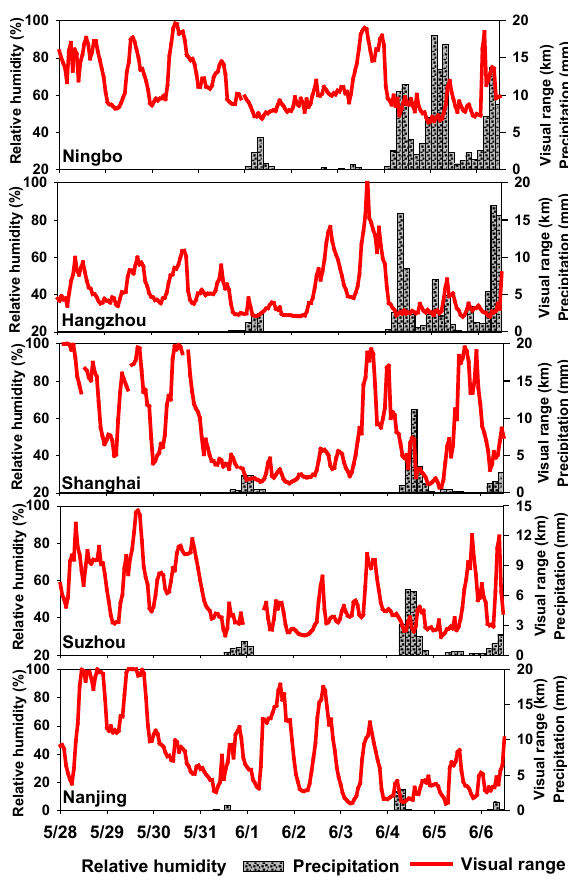
Fig. 5. Relative humidity (black dots), visual range (red line) and precipitation (shaded bar) at each site from 28 May through 6 June, 2011. Fig. 6. Mixing depths (black lines) and wind speeds (red dots) at each monitoring site from 28 May through 6 June 2011.